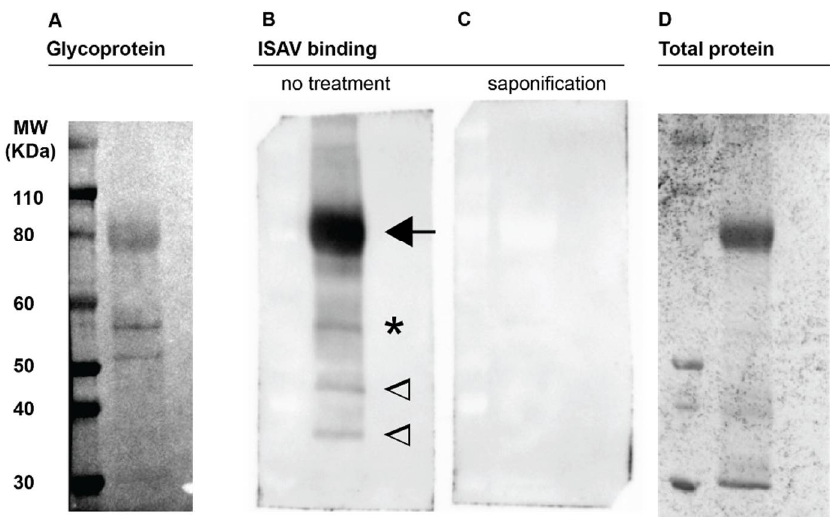
Figure 1. ISAV binds Atlantic salmon erythrocyte membrane glycoproteins. Plasma membrane-enriched erythrocyte lysates were separated by gel electrophoresis under denaturing conditions and blotted to nitrocellulose membranes. ( A ) Periodic acid-schiff staining to visualise glycoproteins. The numbering to the left indicates the weight of the molecular marker in the left lane. ( B , C ) Virus binding assay to blotted membranes from parallel runs, visualising bound antigen by detection of ISAV HE. ( B ) Arrow points to the predominant ISAV-binding glycoprotein-containing band; star indicates a second ISAV-binding glycoprotein-containing band; in contrast, two ISAV-binding bands at 35 and 45 kDa indicated by open arrowheads, did not have obvious corresponding PAS bands. ( C ) Prior saponification of the blotted membrane obliterated all ISAV binding. ( D ) Total protein staining of representative gel. Images show full-length lanes representative of three independent experiments. Original images have been uploaded as supporting